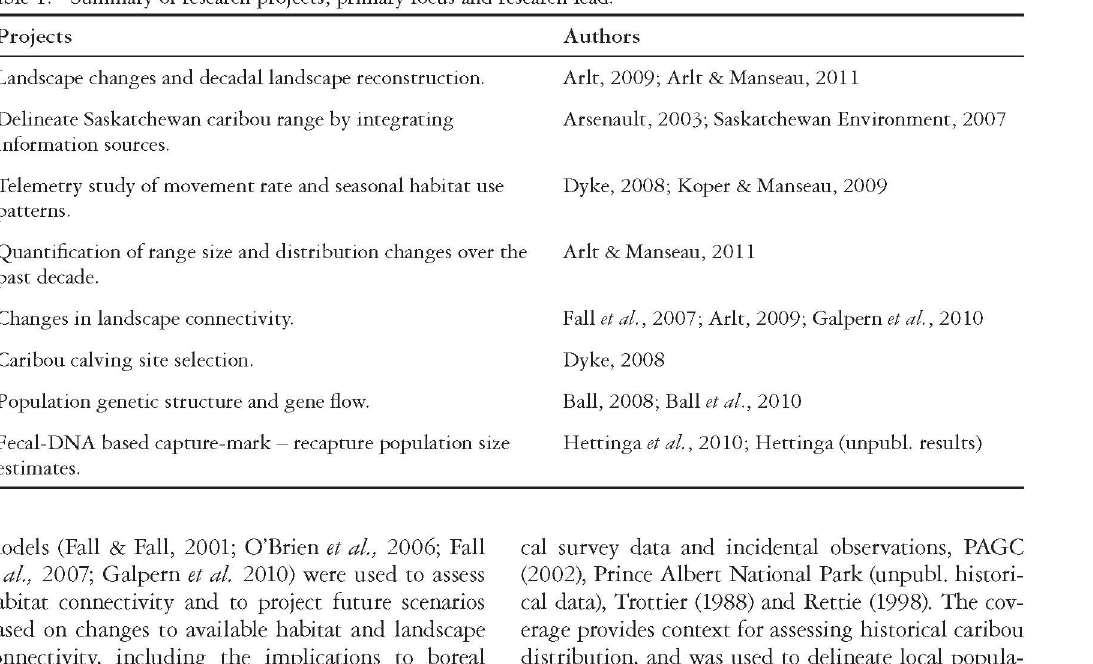
Table 1. Summary of research projects, primary focus and research